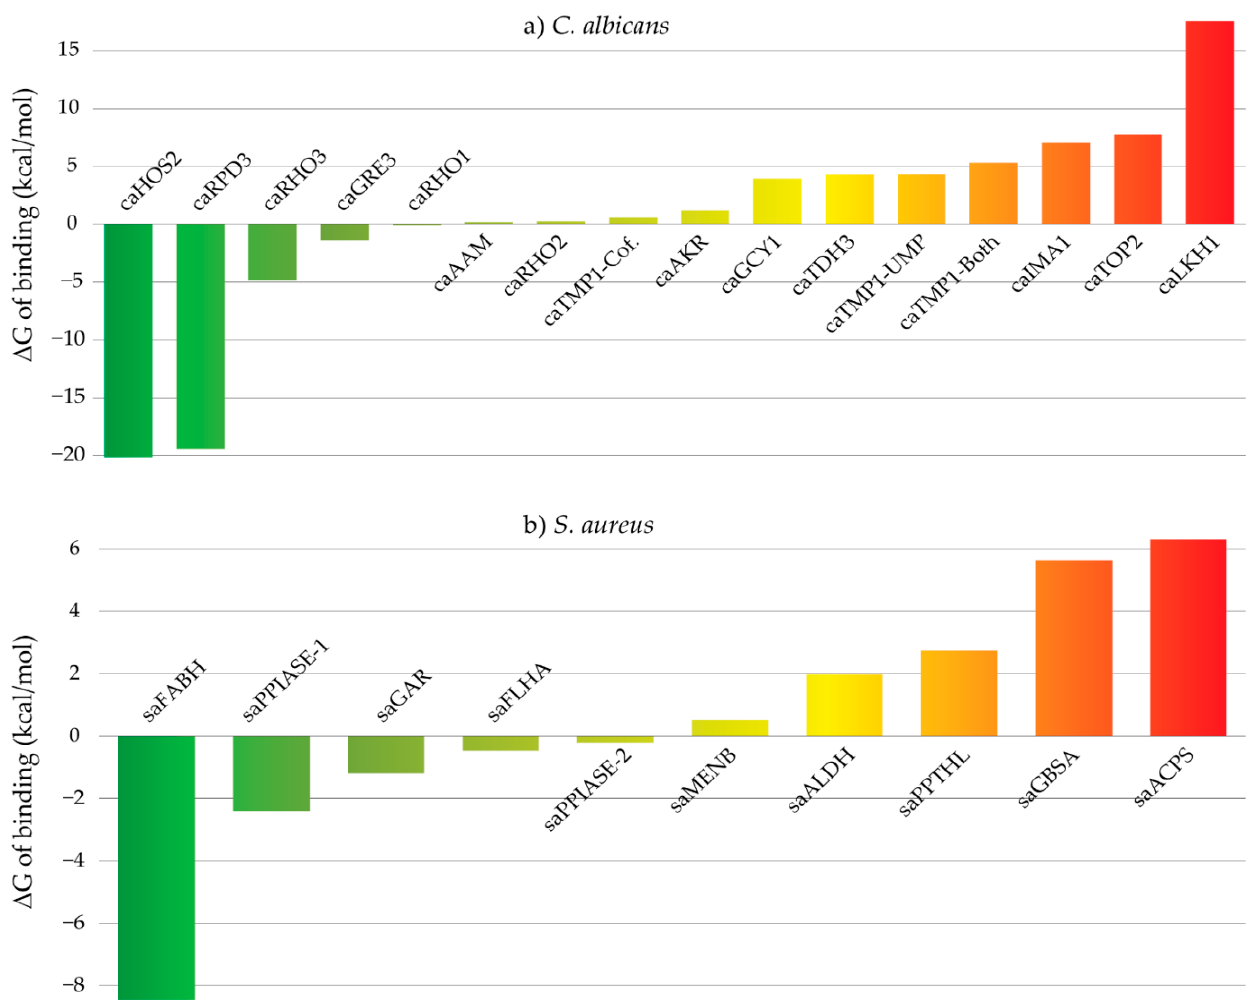
Figure 3. Predicted free binding energies of compounds 6 ( a ) and 18 ( b ) with their predicted targets in C. albicans and S. aureus , respectively. in C. albicans and S. aureus ,